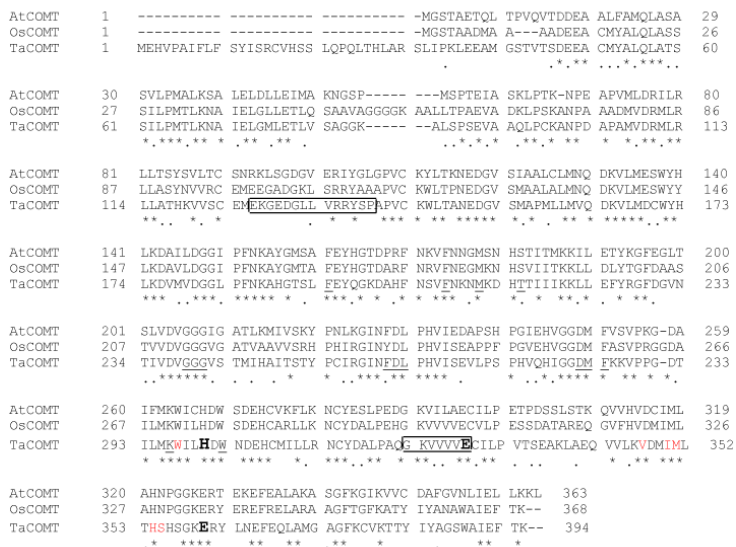
Figure 1. Multiple alignments of TaCOMT. Multiple sequence alignments were constructed with DNAMAN. The three completely identical catalytic residues (His267, Glu295, and Glu327) of caffeic acid 3-O-methyltransferases (COMTs) are shown in bold letters. The SAM-binding sites are underlined. The phenolic substrate binding sites are in red letters. The putative N-acetylserotonin (NAS) binding domains are in boxes. The same amino acids are marked with asterisks (*).